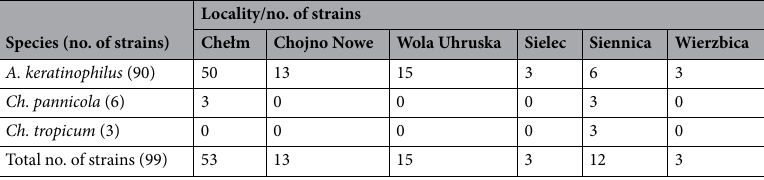
Table 4. Fungal strains of Chrysosporium sp. isolated from rook pellets used in the present study.